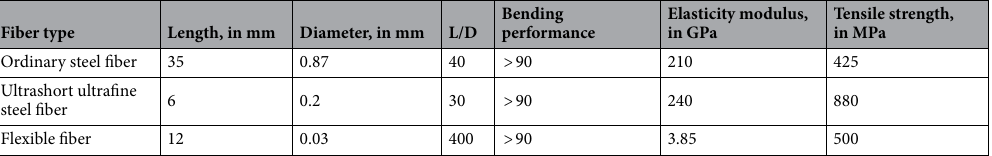
Table 1. Main physical and mechanical properties of the three types of fibres.